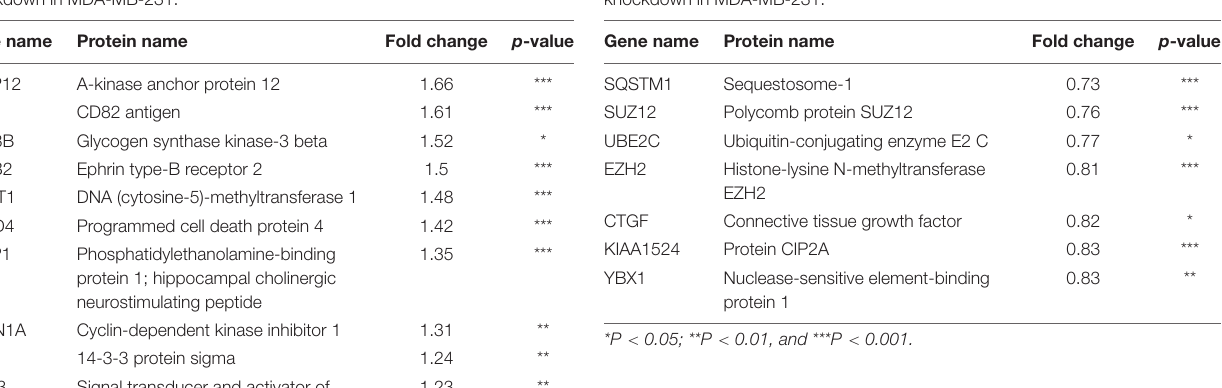
TABLE 1 | Cancer stem cell-related and upregulated proteins by NEDD4 knockdown in MDA-MB-231.